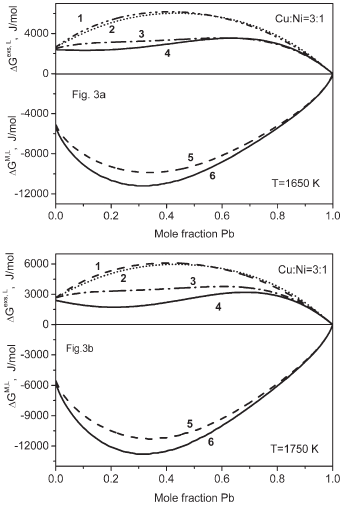
Figure 3. Integral molar Gibbs excess energies ( ∆ G exs,L , J mol -1 ) of the ternary liquid phase calculated (at 1650 K and 1750 K, respectively) along a section with constant molar Cu/Ni ratio equal to 3/1. Curve 1 is calculated using binary optimizations of COST 531 thermodynamic database [1], curve 2 – using GSM [22, 23], curve 3 – ternary optimizations of Wang et al . [24], curve 4 – this work. Curve nos. 5 and 6 show the integral molar Gibbs energy ∆ G M,L , J mol -1 (referred to the liquid state) assessed using ternary optimized parameters of Wang et al . [24] and this work,